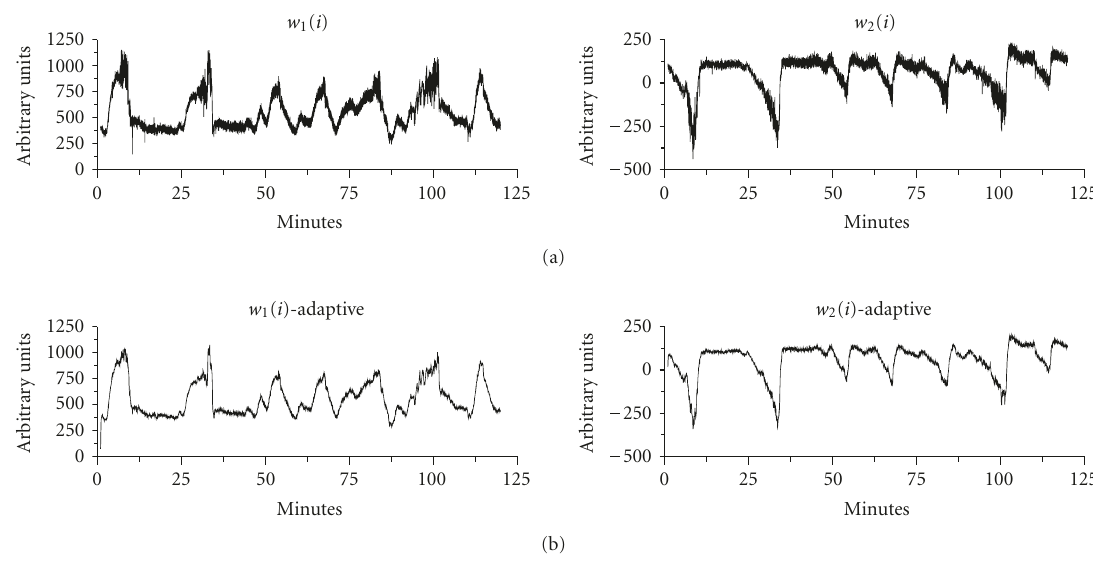
Figure 9: Ischemia and ST-T segment analysis during noisy conditions. The KLT coe ffi cient series’ w 1 ( i ) and w 2 ( i ) are obtained using either (a) the inner product or (b) the inner product combined with adaptive estimation. Note the significant reduction in noise level from (a) to (b), while the information on ischemia episodes remains essentially